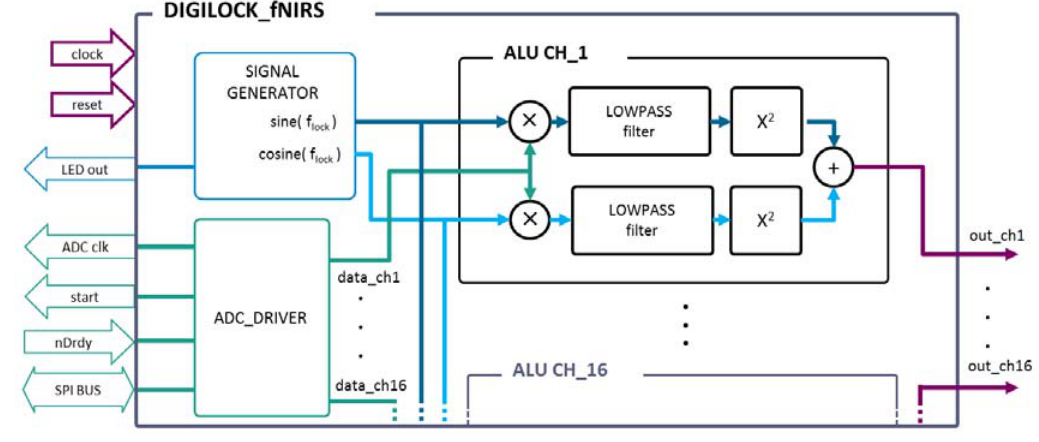
Figure 2. Block diagram of the designed FPGA entities.